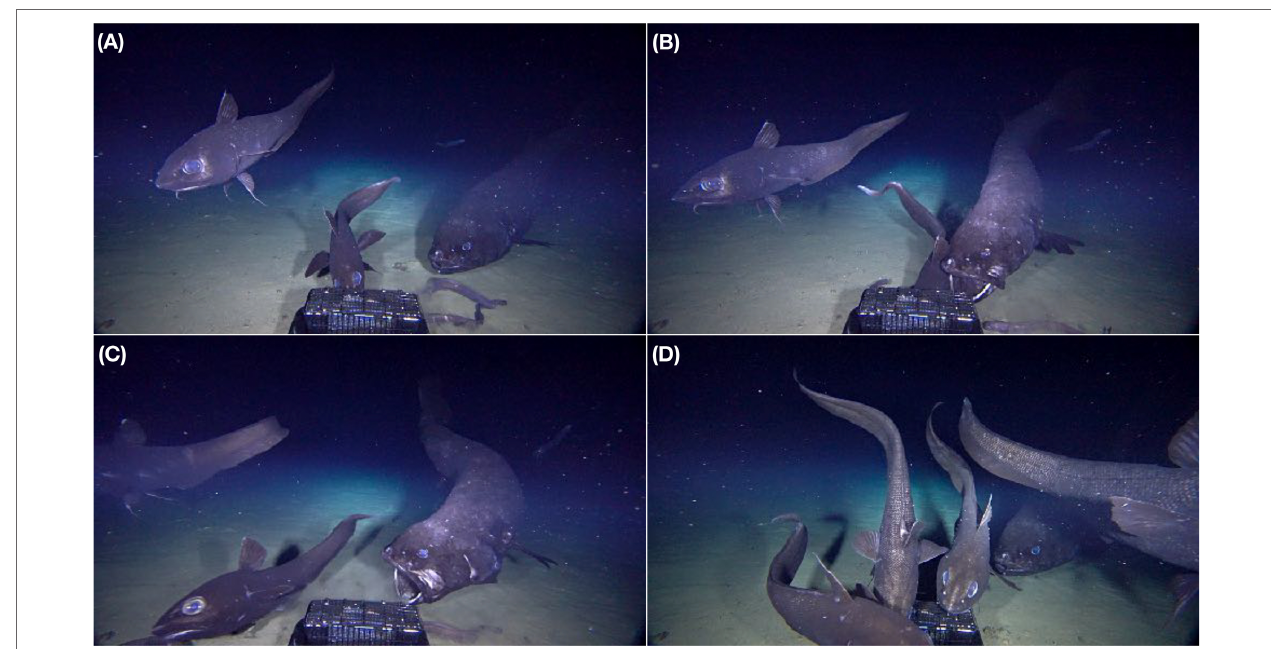
FIGURE 2 | Yokozuna Slickhead Narcetes shonanmaruae . In situ video grabs recorded using a baited camera system at a depth of 2,091 m south of Genroku Seamount during cast no. POP1-1 on October 14, 2021. (A) First arrival of a Yokozuna Slickhead individual (on the right side) at the baited camera system; (B) First threatening behavior toward Pacific Grenadiers Coryphaenoides acrolepis ; (C) Second threatening behavior to the Pacific Grenadiers; (D) Second arrival of the Yokozuna Slickhead at the baited camera